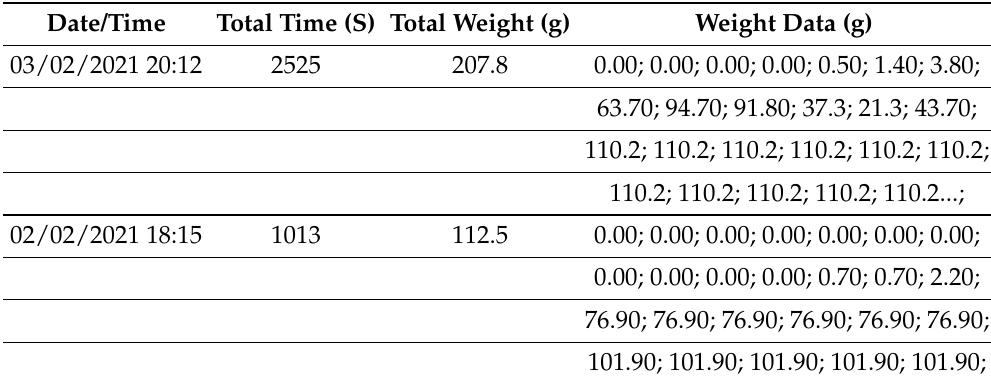
Table 2. Data samples collected from the experiments with the household